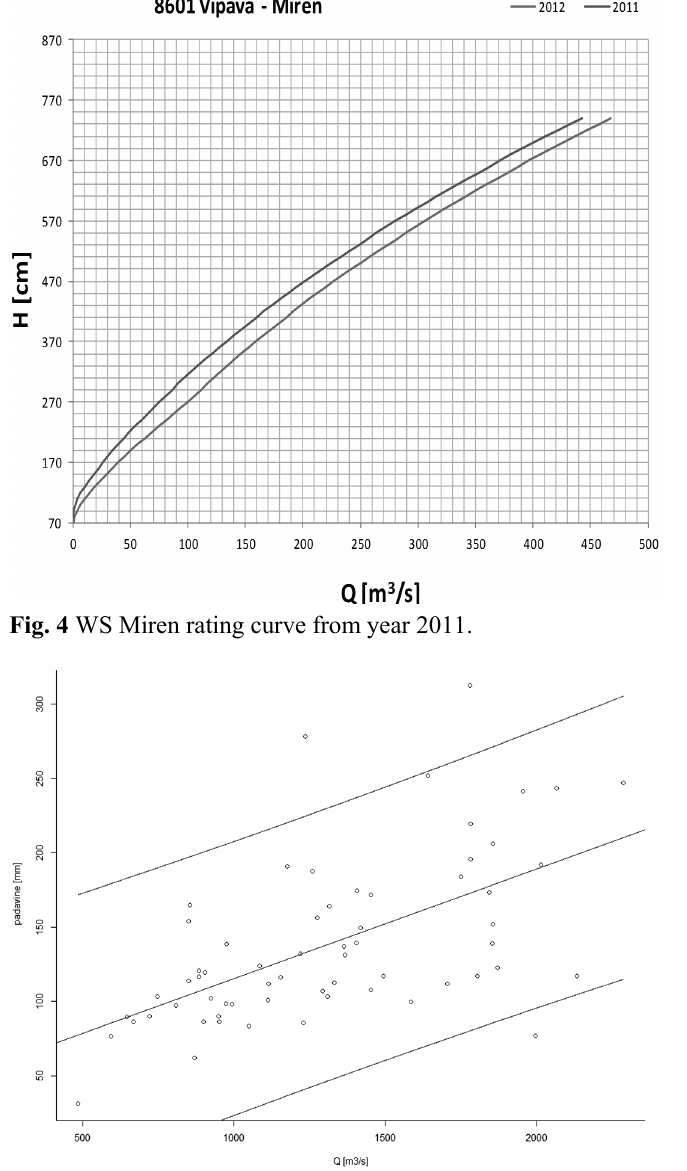
Fig. 5 Scatterplot with regression line and the 95% confidence interval for stations Solkan (discharge) and Kobarid